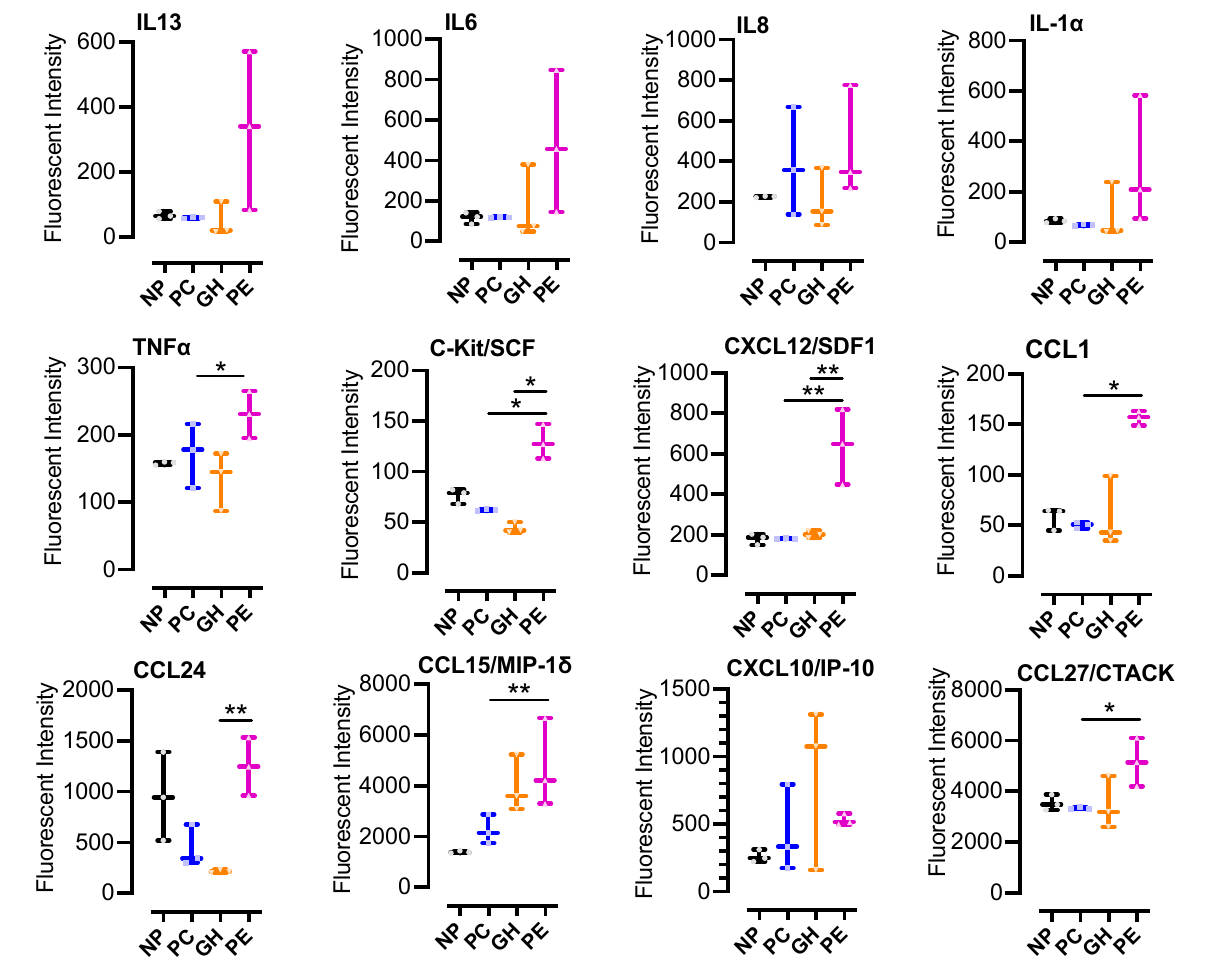
Figure 2. Multiplex immunoassay indicates the elevation of plasma CCL1 and CCL27, and multiple cytokines in preeclamptic patients: plasma samples ( n = 3, per group) from non-pregnant (NP), healthy pregnant or pregnant controls (PC), gestational hypertensive (GH) and preeclamptic (PE) participants were analyzed for the indicated cytokine/chemokine as biomarkers of systemic inflam- mation. The multiplex immunoassay was performed with the Millipore MILLIPLEX Cytokine Array Assay Kit, and the results were analyzed with a Bio-Plex 200. Sample analysis was performed in duplicates for each participant, using the Bio-Plex Multiplex System, powered by Luminex xMAP technology. Data were then analyzed using GraphPad Prism 9 and were summarized in box-and- whisker plots for each biomarker. The plots show minimum to maximum values and dots/points represent all raw data (replicate experiments inclusive). The medians and interquartile ranges of data are represented by the horizontal line through the box and width of the box, respectively. Statisti- cal significance was determined by 1-way ANOVA and Bonferroni adjusted post hoc independent samples t -tests. p < 0.05 (*) or p < 0.01 (**) were considered